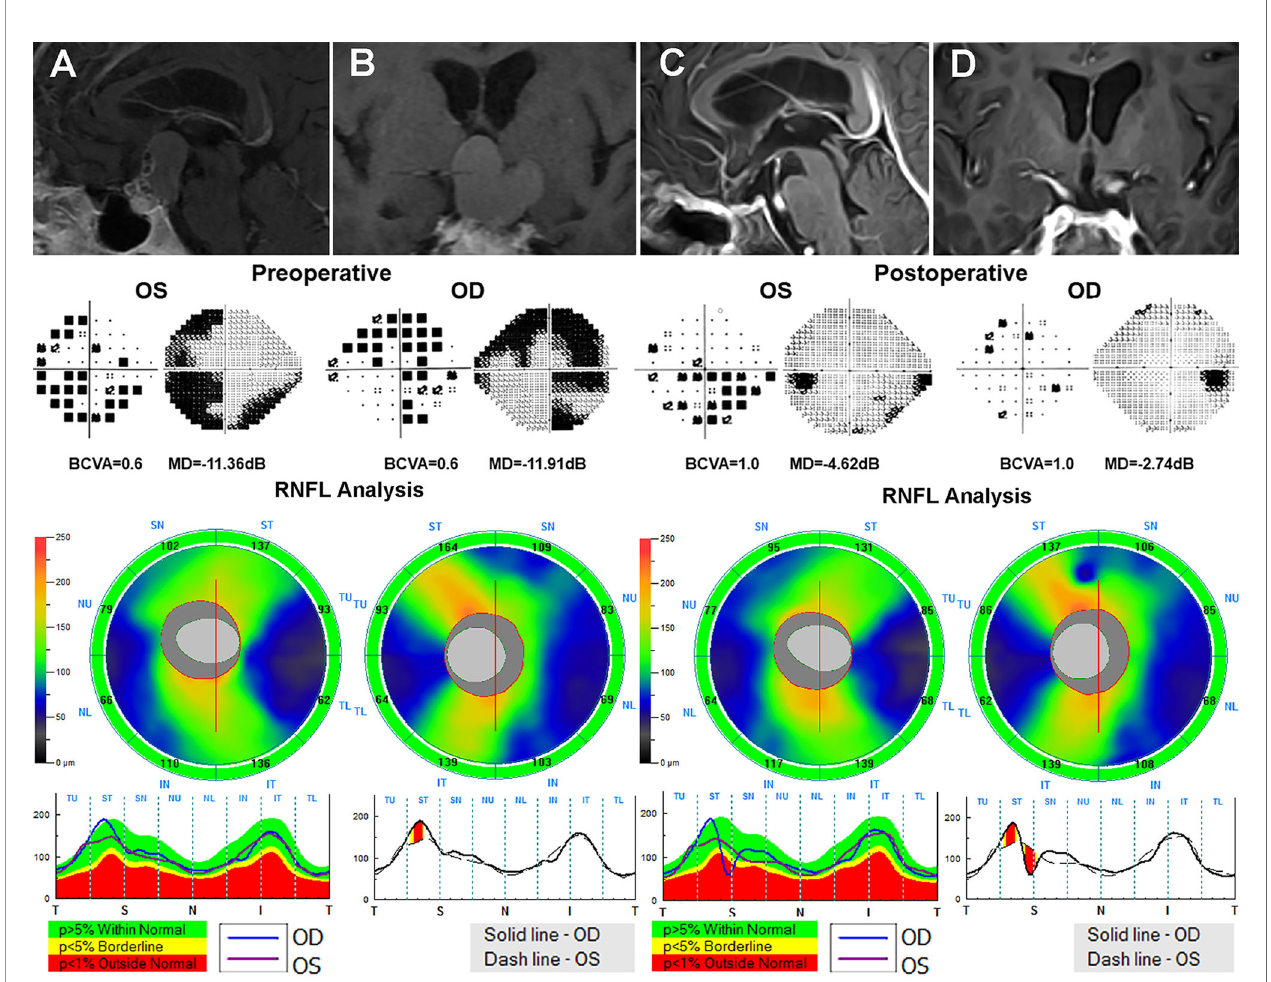
FIGURE 4 | A 59-year-old male patient who underwent the EEES for craniopharyngiomas was examined preoperatively and 3 months after surgery. Contrast-enhanced T1-weighted MRI scans (A, B) suggested a suprasellar cystic-solid lesion compressing downward the optic chiasma. Preoperative Humphrey VF test showed mainly temporal VF defects in both eyes. Preoperative OCT suggested normal cpRNFL thickness in both eyes. After total resection of the tumor (C, D) , the optic nerves were suf fi ciently decompressed, the VA and VF in both eyes dramatically improved after surgery. EEES, extended endoscopic endonasal surgery; OCT, optical coherence tomography; cpRNF, circumpapillary retinal nerve fi ber layer; BCVA, best-corrected visual acuity; MD, mean deviation; VA, visual acuity; VF, visual fi